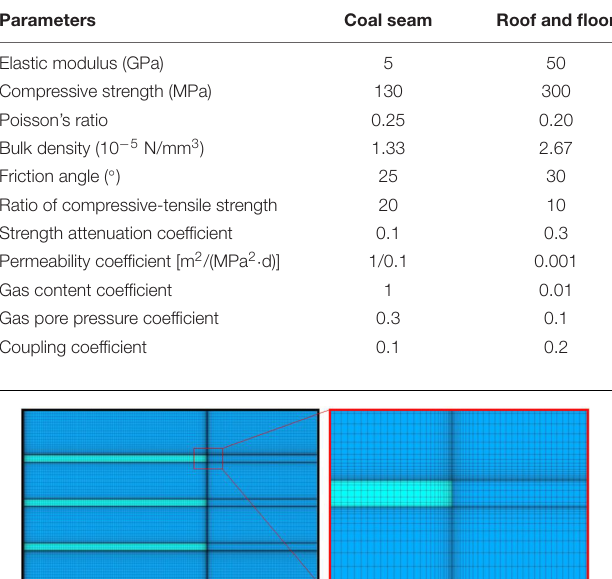
TABLE 1 | Mechanical parameters of the numerical model.